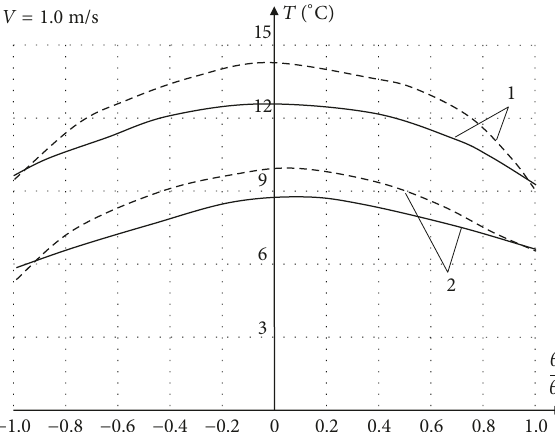
Figure 6: Temperature change in the hub for one stroke of the plunger for velocity of plunger motion 𝑉 = 1.0 m/s.